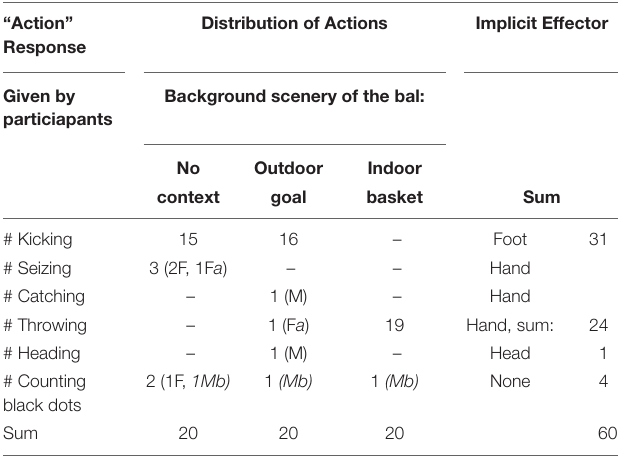
TABLE 1 | Free self-intended virtual